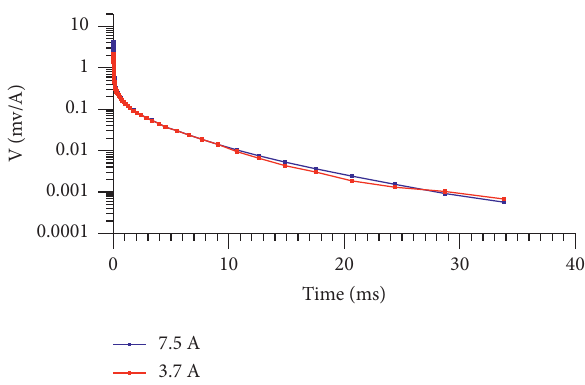
Figure 7: Comparison of V ( t )/ I attenuation curves of power supply current of 3.7A and 7.5A.